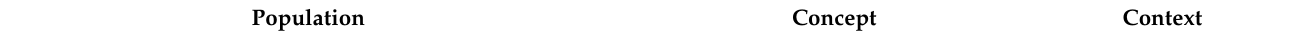
Table 1. PCC element for defining the eligibility criteria of the studies for the research question. Population Concept Context Health policy makers, healthcare providers, health facilities, government and non-government organizations (e.g.,